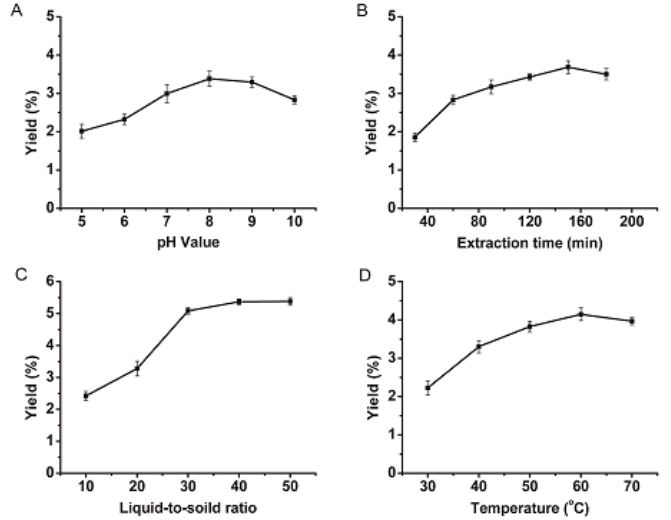
Figure 1. The effect of different extraction parameters: pH value ( A ), extraction time ( B ), liquid-to-solid ratio ( C ), temperature ( D ) on yield of PSAF.